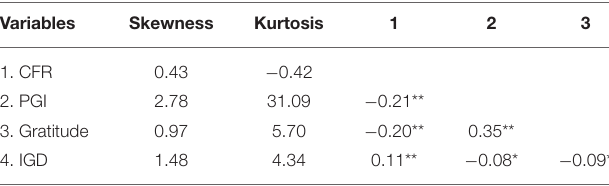
TABLE 2 | Skewness, kurtosis, and correlation coefficients of key